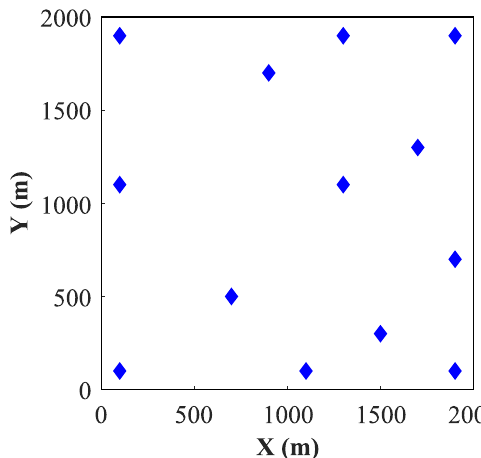
Figure 4. Optimal wind farm layout.